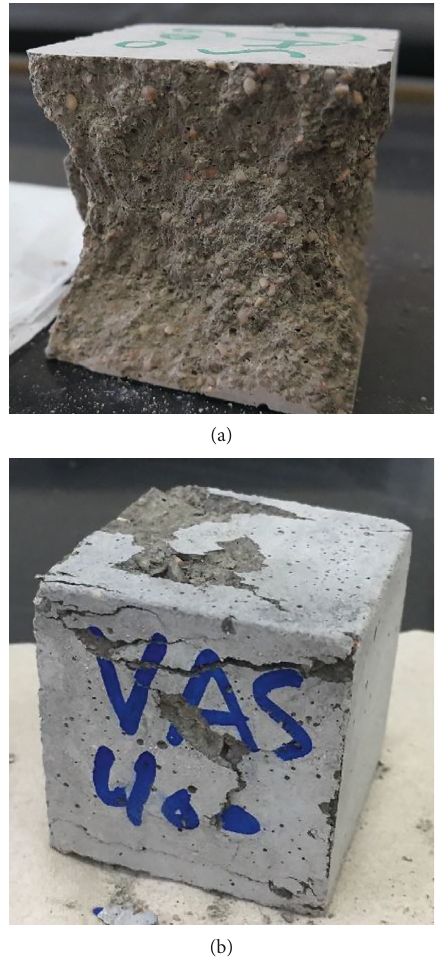
Figure 8: Failure mode of air-cooled specimens after exposure to 400 ° C (a) specimen with volcanic ash only (VA20); (b) specimen with volcanic ash plus slag